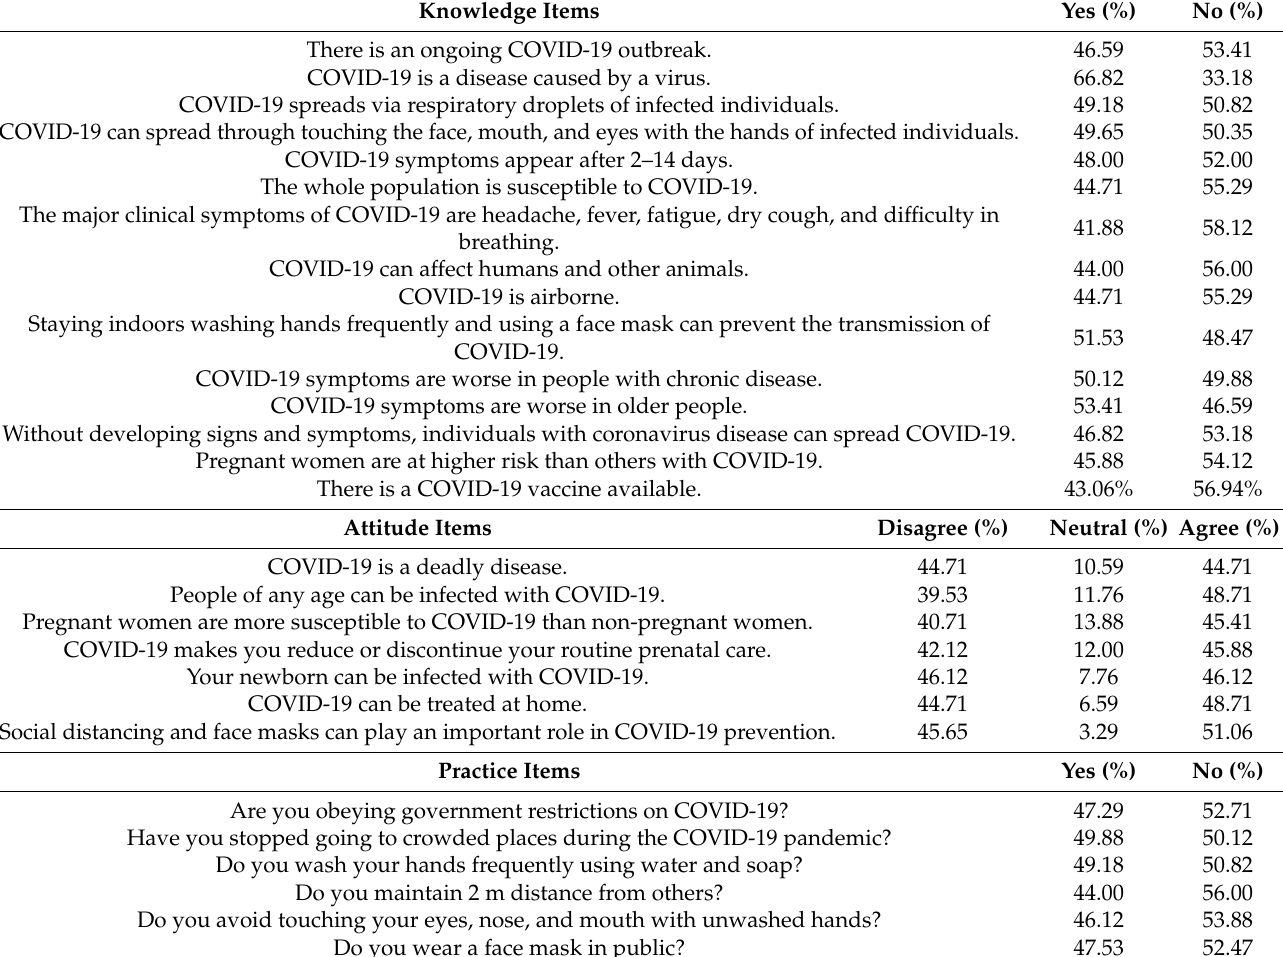
Table 2. Distribution of participants’ KAP towards COVID-19 ( n =